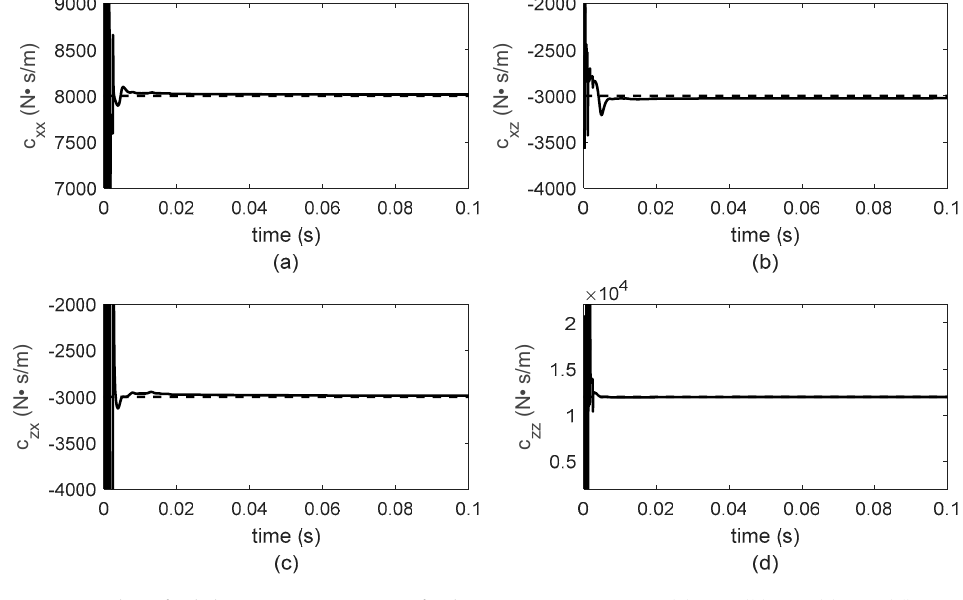
xx , ( b ) c xz , ( c ) c zx , ( d ) c zz